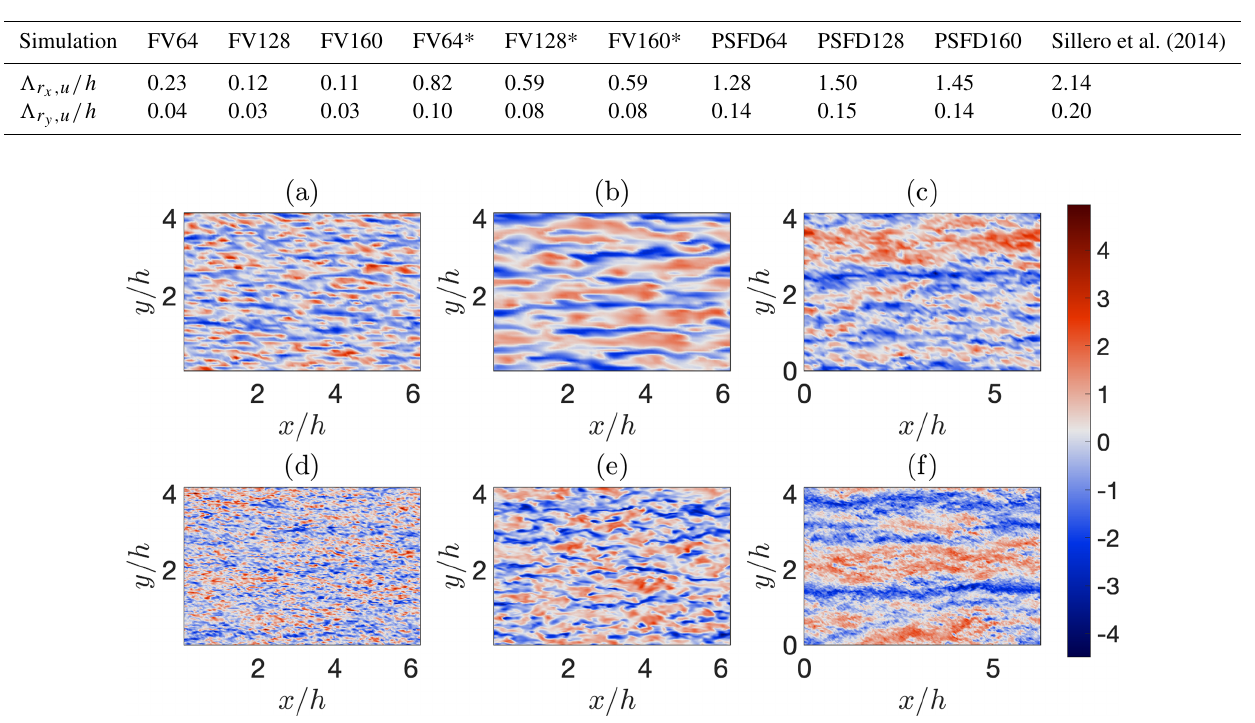
Table 4. Integral lengths at height z/h ≈ 0 . 15.